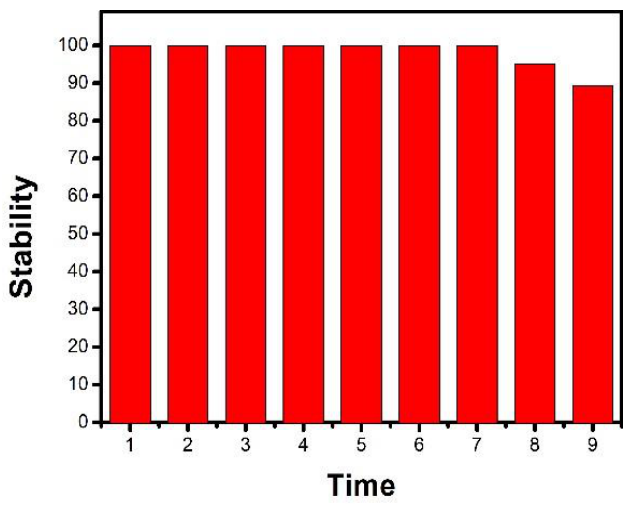
Figure 6. Relationship between time and response of the CdS-TiO 2 NTs electrode.